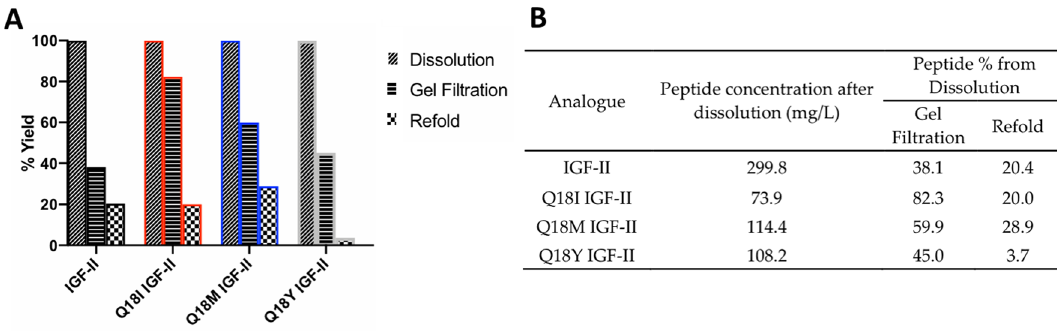
Figure 2. ( A ) Concentration at gel filtration and refold steps in the purification of Q18 IGF-II analogue fusion proteins. Yield is expressed as a percentage of the concentration after dissolution (100%) (data from Fig. 2A presented in B ). ( B ) Table of protein concentration at dissolution (mg/L) and then yield at subsequent steps expressed as a percentage of each of the analogue concentrations at